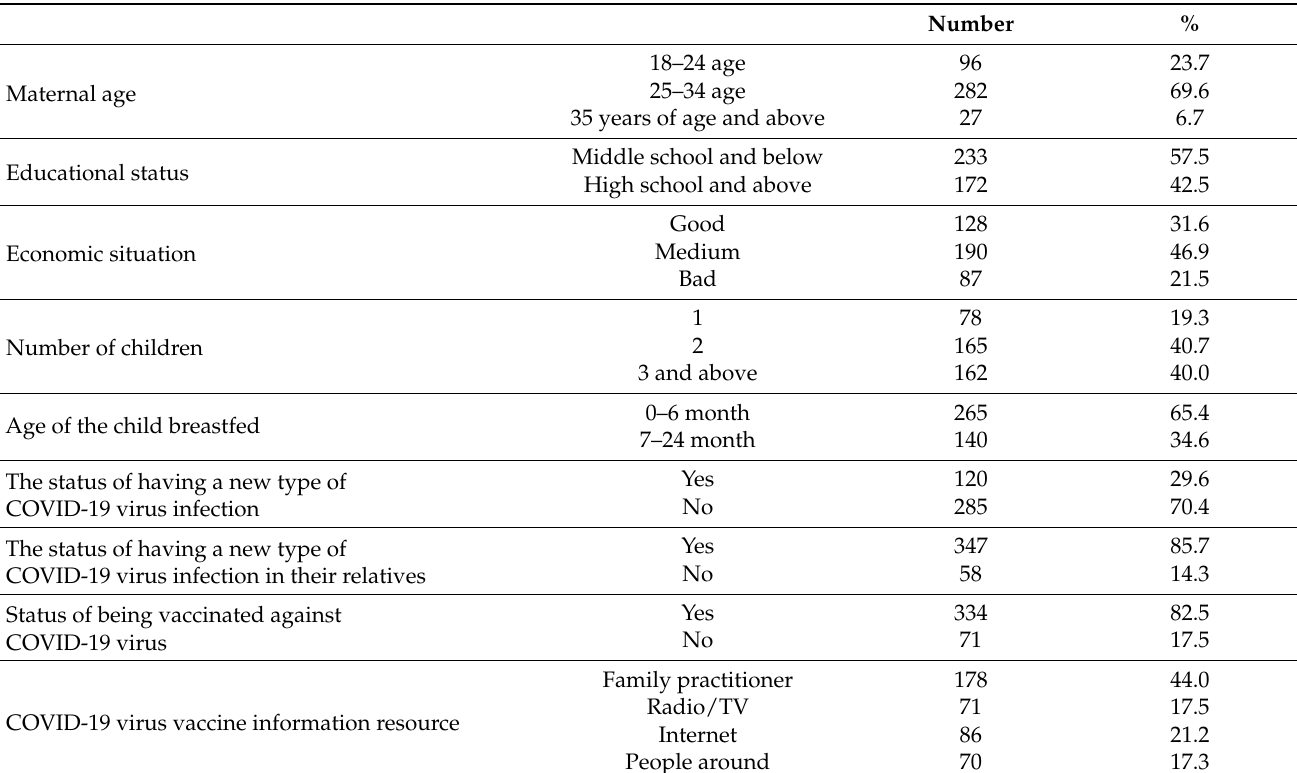
Table 1. Descriptive Characteristics of the Mothers Participating in the